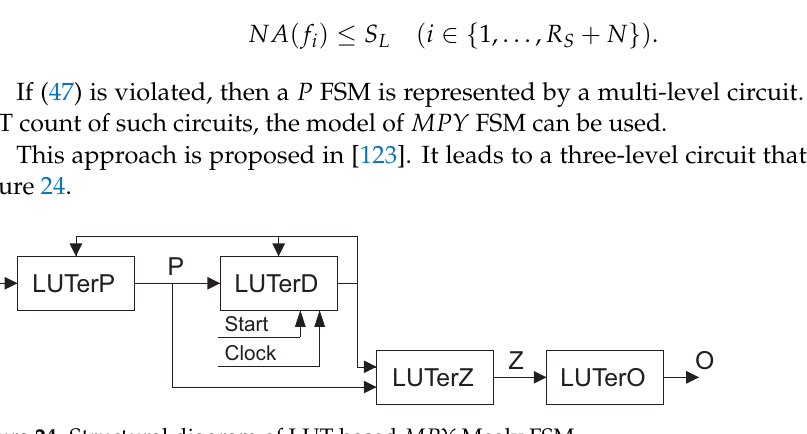
Figure 24. Structural diagram of LUT-based MPY Mealy